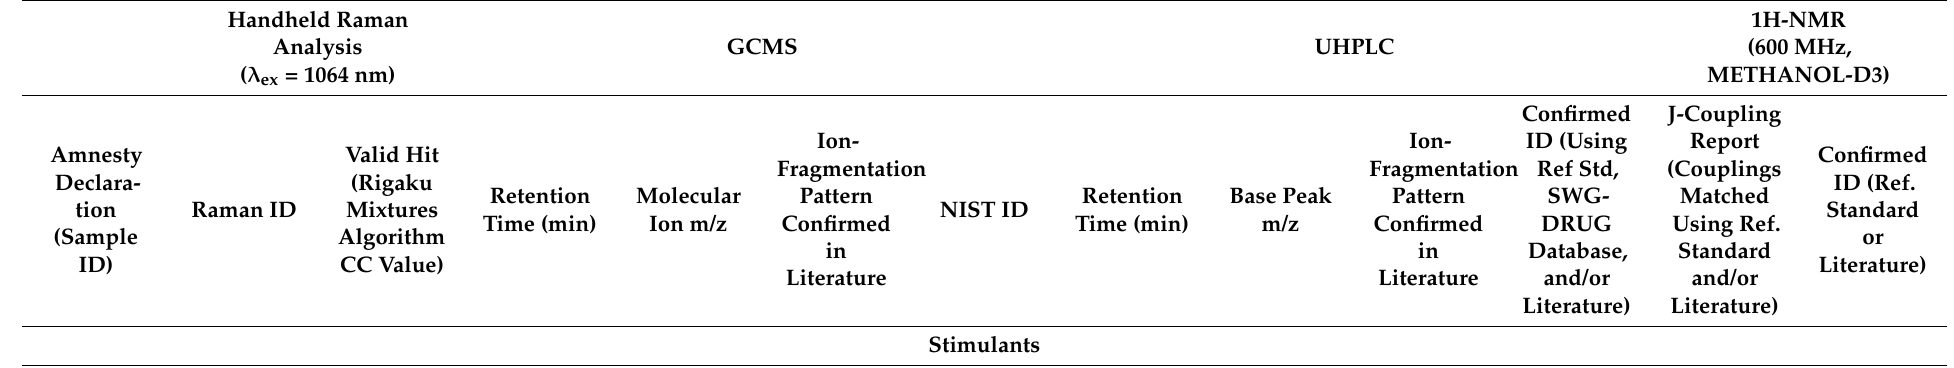
Table 2. Summary of qualitative and analysis of surrendered samples using handheld Raman spectroscopy, GC-MS, UHPLC-MS, and 1 H